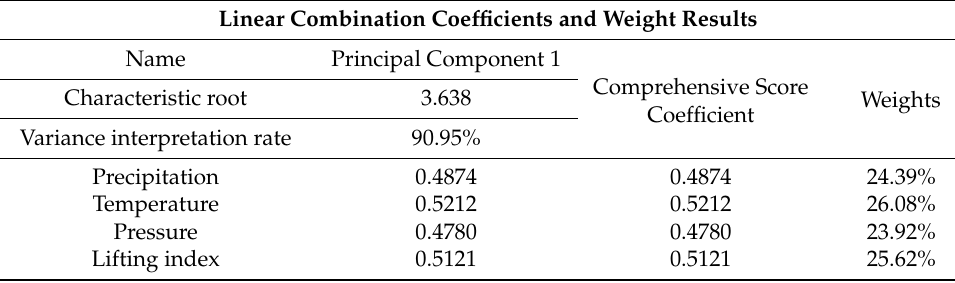
Figure 6. Gravel diagram of principal component analysis of meteorological factors in Fenwei Plain. Table 3. Linear combination coefficients and weight results.